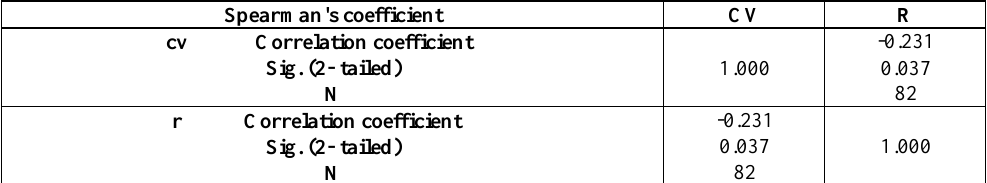
Table 5. Correlation results between rating and stock prices change the coefficient of variation